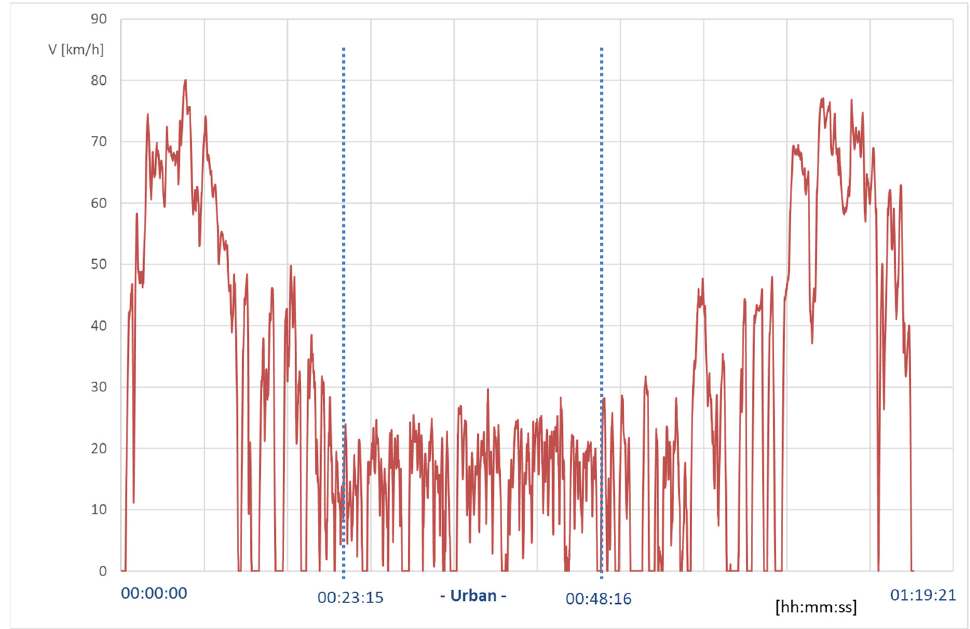
Figure 7. Driving cycle of the test route used in the Toyota Yaris 2020 test drives. Table 2. Summary of average percentage values ZEV mode parameters of Yaris Hybrid 2017 and 2020. Parameter Below are the results of the analysis of the operating parameters in ZEV mode.